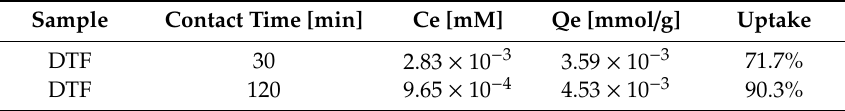
Table 3. Ce and Qe values for DTF at different contact times with NSs.